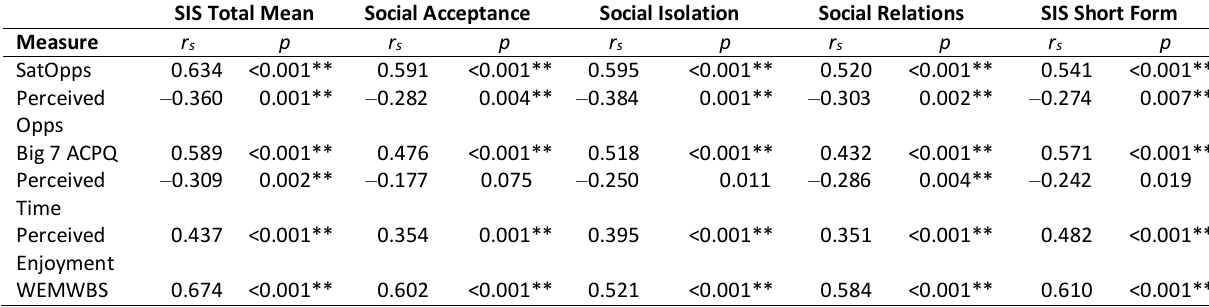
Table 5. Spearman’s correlations between the SIS and other